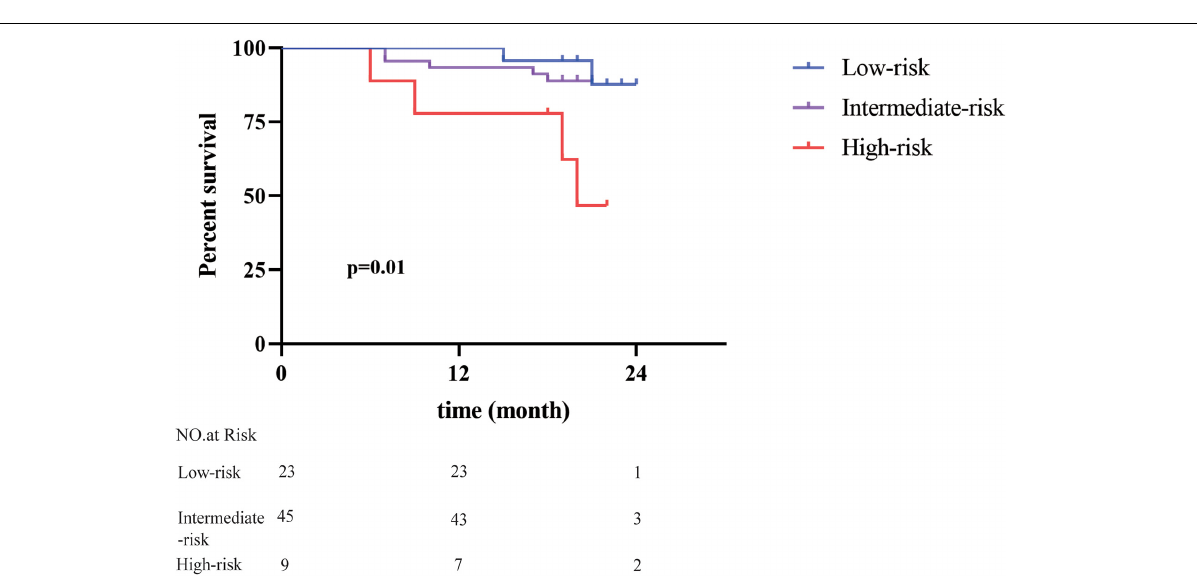
FIGURE 2 | A seven-gene signature defined risk scoring was constructed to predict the overall survival of patients with HCC after radical resection. (A) A total of 129 patients was divided into three groups based on the risk score (ranged from 1 to 14). Patients with a risk score of less than 5 were defined as low risk. Patients with a risk score between 5 and 9 were classified into the intermediate-risk group. Patients with a risk score greater than 9 were defined as a high risk. (B) The difference in overall survival among the three groups was statistically significant ( p = 0.0016) performed by multivariate Cox proportion model.